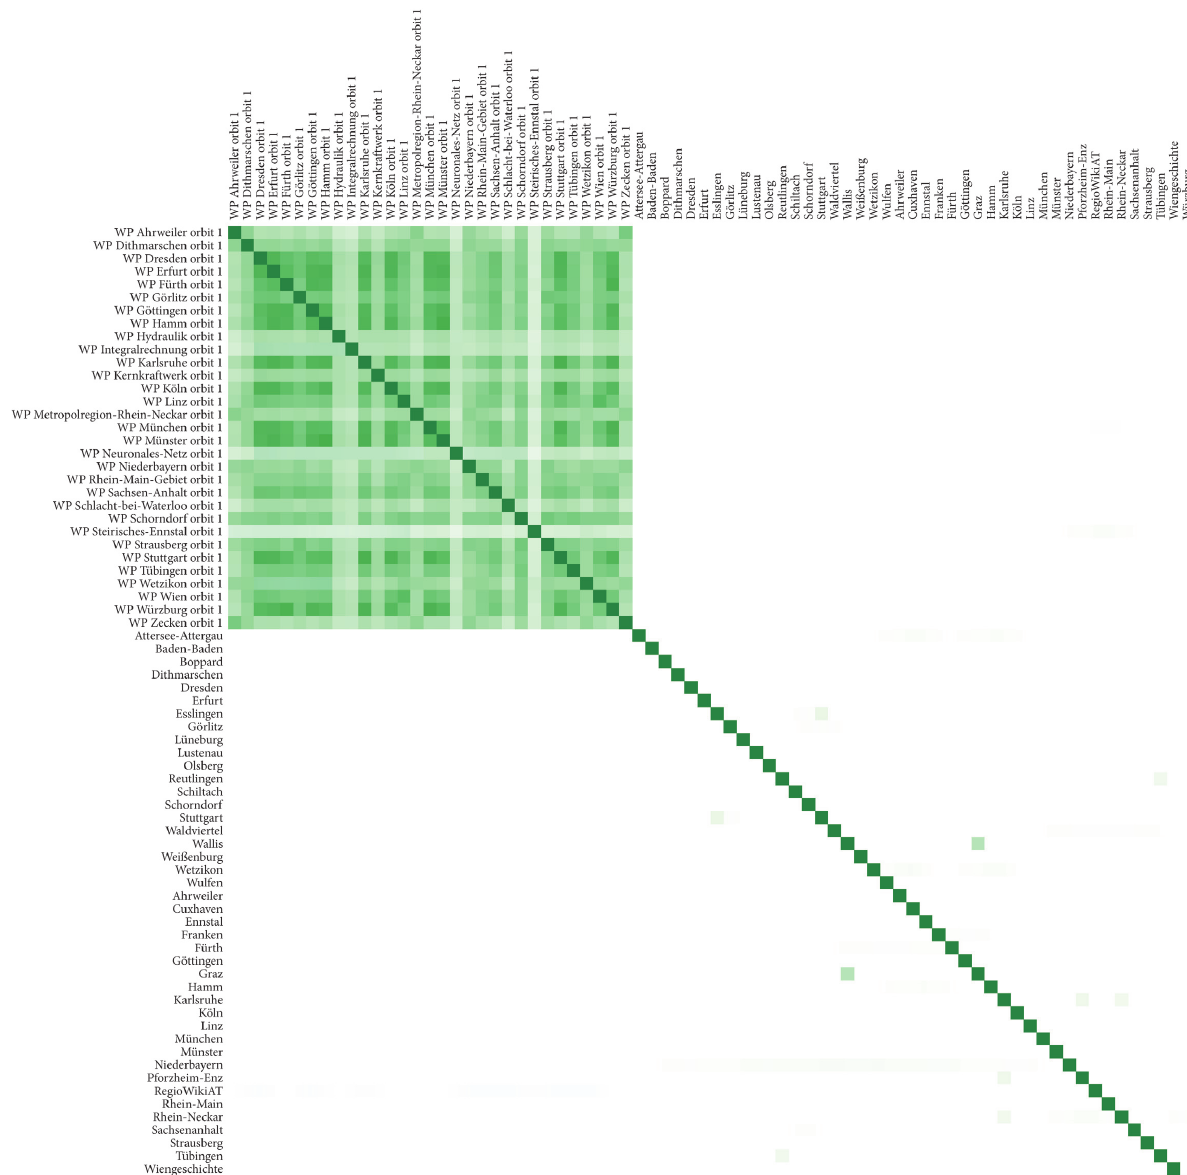
Figure 26: The Fuzzy Jaccard overlap of the communities of registered authors of the wikis in the corpora C WP-R EGIO -1, and WP-O THERS -1 weighted by means of the writing activities of the authors: the greener the link, the higher the fuzzy